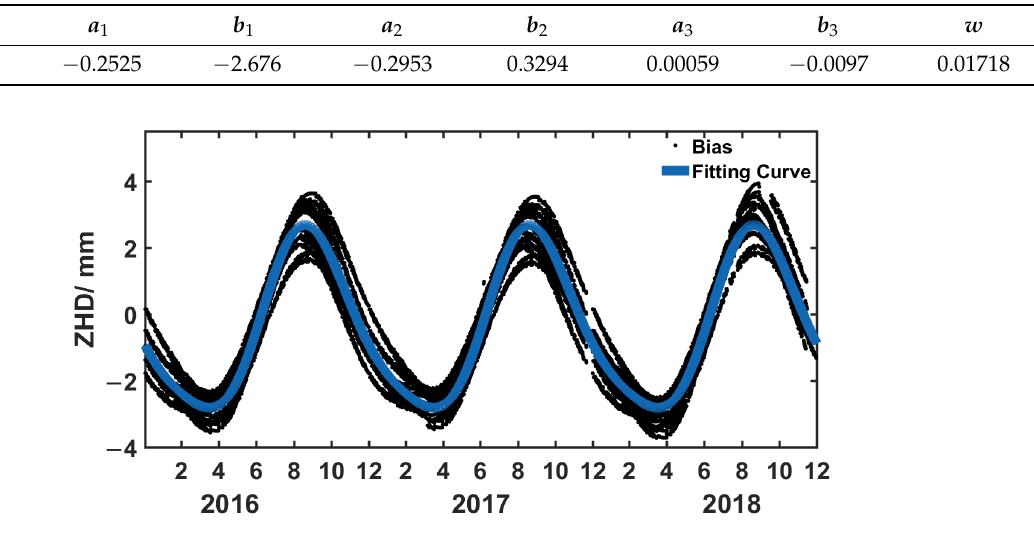
Figure 3. Bias and fitting curves of the GPT3-ZHD bias in the Yangtze River Delta region during 2016–2018.